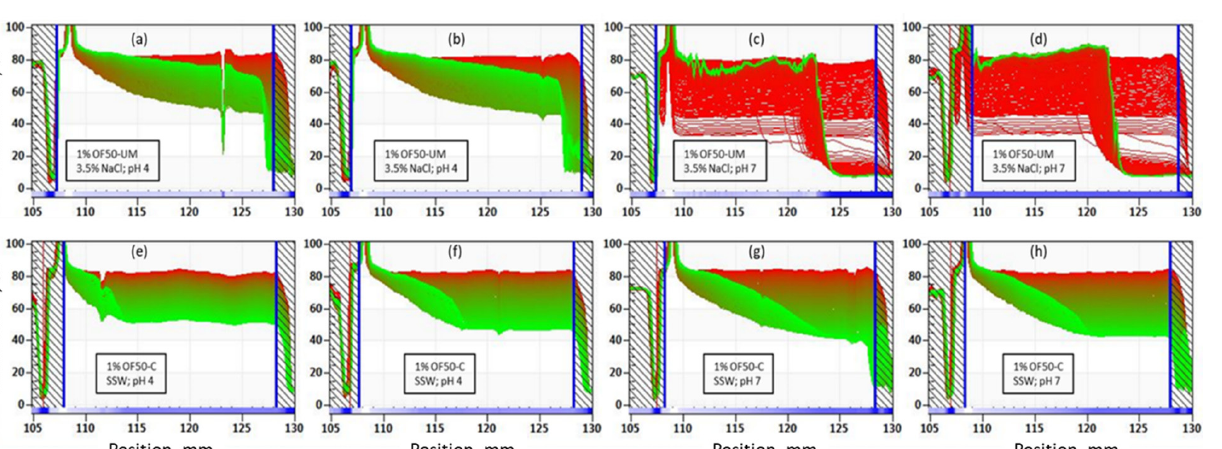
Figure 6. Transmission ( Δ T) profiles obtained by Turbiscan TM at 60 °C for 1 wt.% OF50-M nanoparticles in ( a ) SSW and ( b ) 3.5% NaCl brine for 1-week duration.